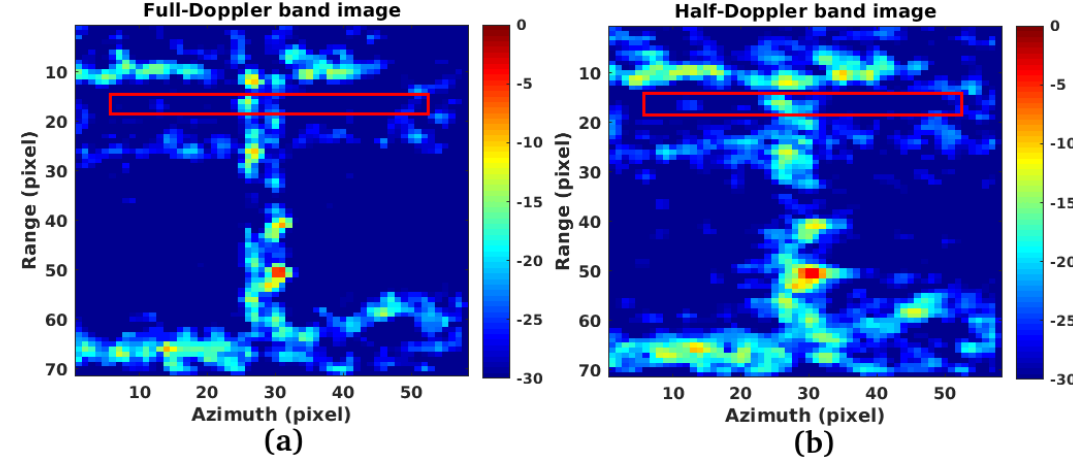
Figure 9. SAR images: ( a ): Full resolution. ( b ): Half resolution.